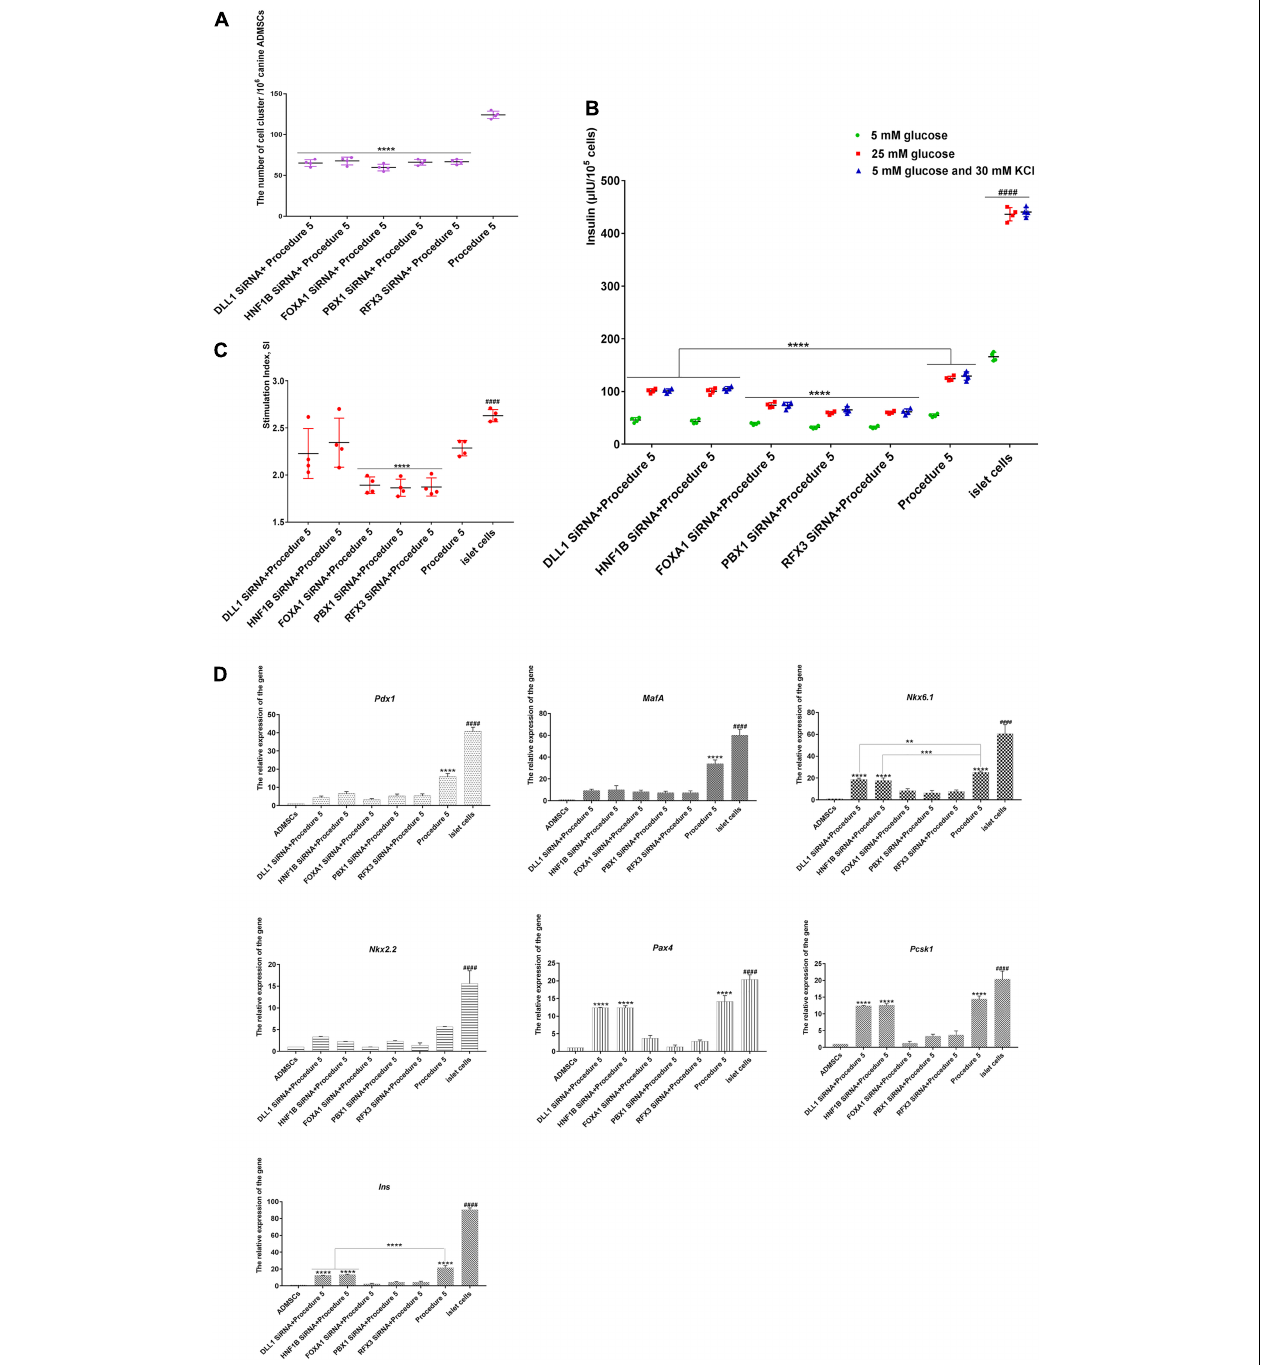
FIGURE 8 | SiRNA-mediated genes silencing. (A) After SiRNA infects canine ADMSCs, the numbers of cluster in gene silencing groups were significantly less than that of the non-silenced group (**** p < 0.0001) ( n = 4). (B) After the stimulation of low glucose (5 mM), high glucose (25 mM), 5 mM glucose, and 30 mM KCl, the secretion of insulin in procedure 5 was significantly higher than that of genes silence groups (**** p < 0.0001). The secretion of insulin in FOXA1 SiRNA + Procedure 5, PBX1 SiRNA + Procedure 5, and RFX3 SiRNA + Procedure 5 was lowest (**** p <0.0001), they were all lower than the mature islet cells group (#### p < 0.0001) ( n = 4). (C) The glucose stimulation index of FOXA1 SiRNA + Procedure 5, PBX1 SiRNA + Procedure 5, and RFX3 SiRNA + Procedure 5 was lower than procedure 5, DLL1 SiRNA + Procedure 5, HNF1B SiRNA + Procedure 5 (**** p < 0.0001), islet cells group was highest (#### p < 0.01) ( n = 4). (D) The silence of Foxa1 , Hnf1b , Dll1 , Pbx1 , Rfx3 can reduce expression of islet cascade regulatory genes. Islet cascade regulatory genes were most significantly decreased when Foxa1 , Pbx1 , Rfx3 genes were silenced separately compared with the non-silenced group. After Foxa1 , Pbx1 , and Rfx3 were silenced, the expression of Nkx6.1 , Pax4 , Ins , and Pcsk1 was significantly lower than that of the Hnf1b and Dll1 silencing groups. There was no significant difference in the expression of Nkx2.2 (**** p < 0.0001; *** p < 0.001; ** p < 0.01). The expression of all genes was lower than the mature islet cells group (#### p < 0.0001).